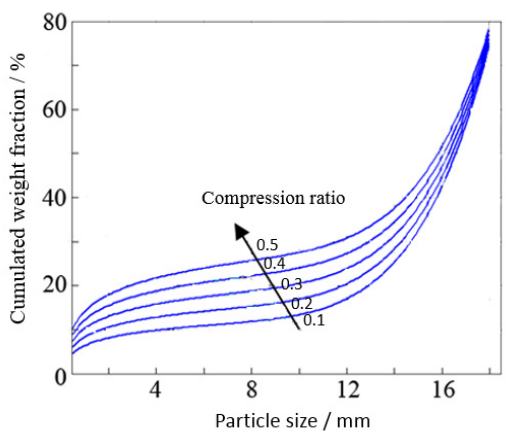
Figure 6. Breakage function model.